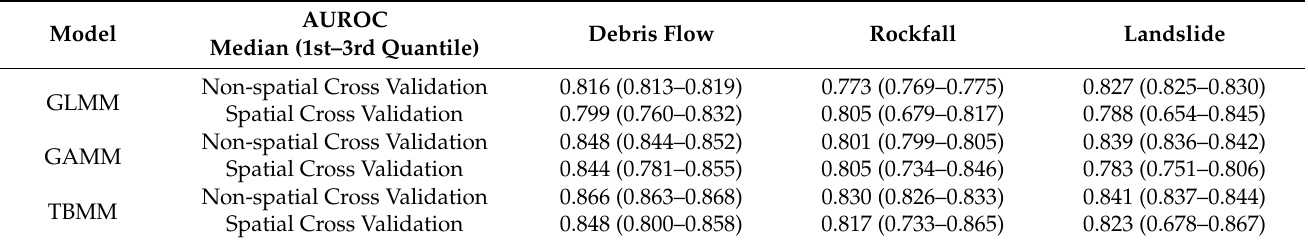
Table 4. Cross-validation results of three mixed models for mass